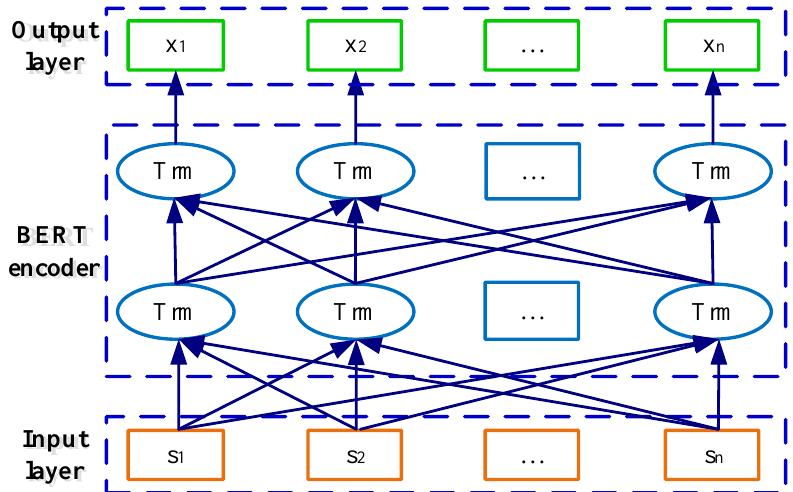
Figure 5. Structure of the BERT model.